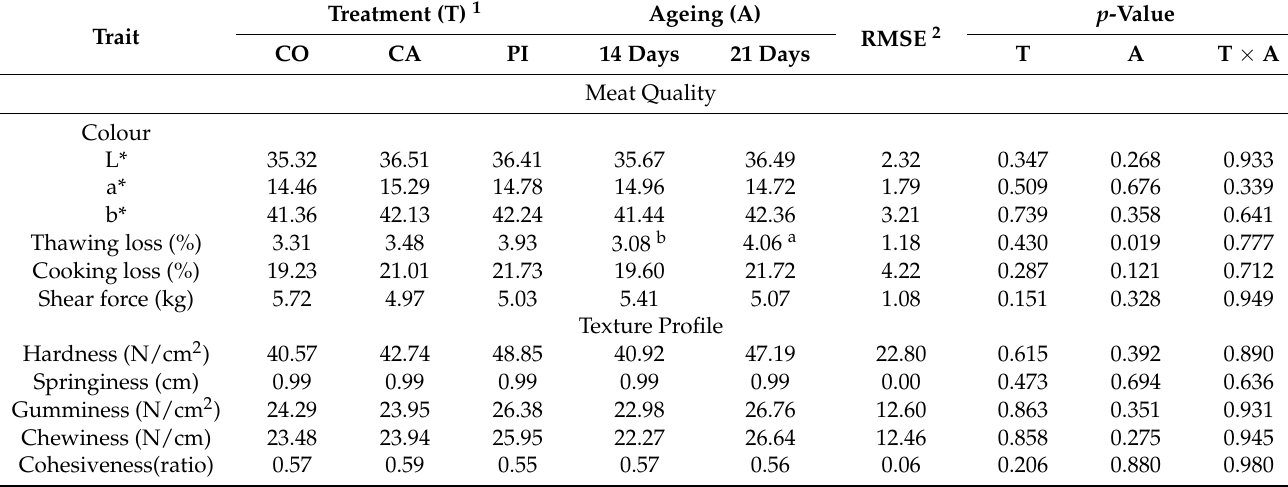
Table 1. Effect of starch source of concentrate and ageing period on meat quality and texture profile of fattening dairy steers. Trait